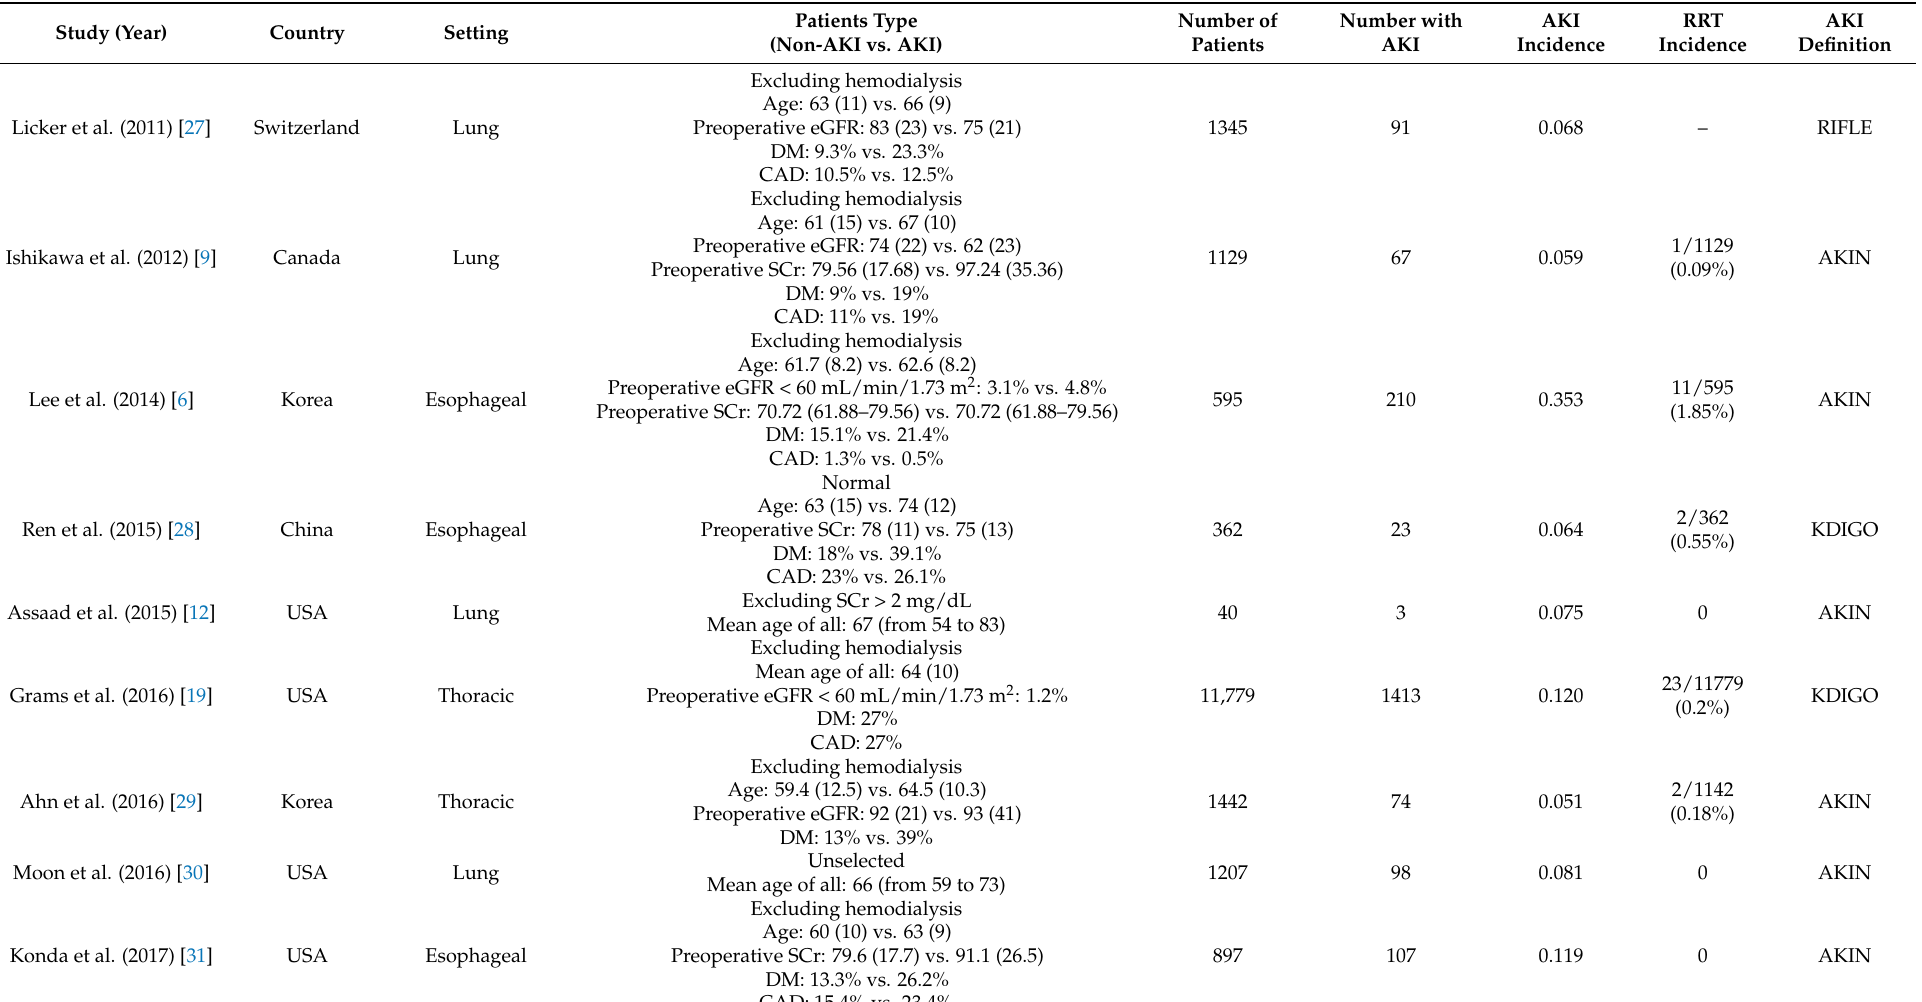
Table 1. Main characteristics of the studies included in the